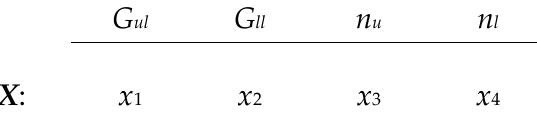
Figure 6. Structure of solution encoding.